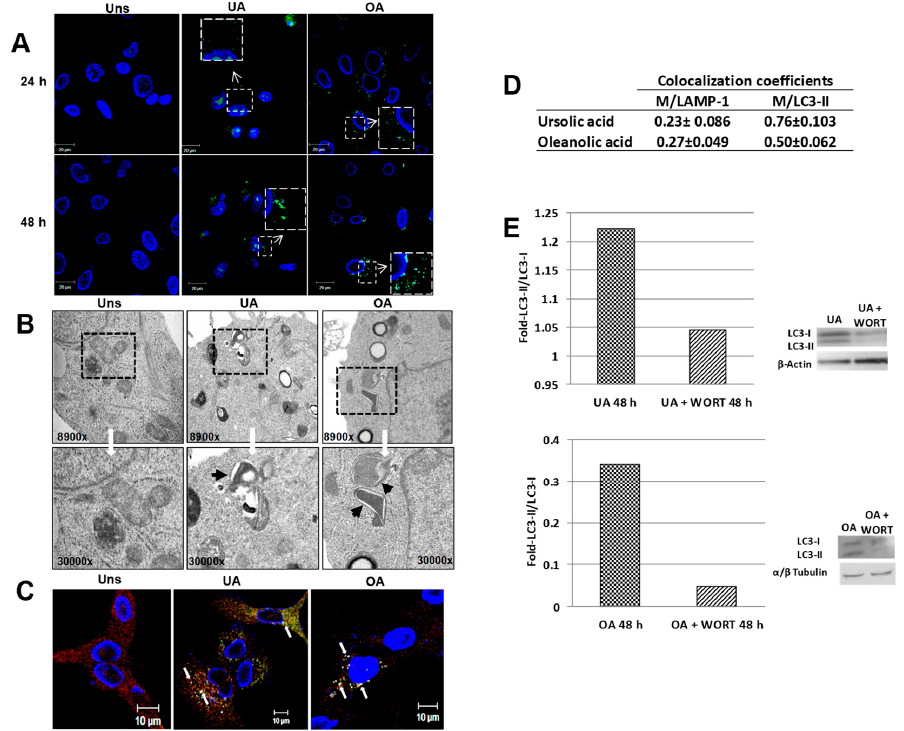
Figure 2. Ursolic and oleanolic acids induced autophagy in A549 human lung cancer cells. ( A ) A549 cells unstimulated (Uns) or stimulated with 10 µg/mL ursolic acid (UA) or 20 µg/mL oleanolic acid (OA) for 2, 6, 24, and 48 h were fixed with 4% paraformaldehyde and washed with PBS. Subsequently, the cells were incubated with an anti-LC3A/B antibody at 4 °C overnight and an anti-goat IgG-FITC antibody at 37 °C for 4 h. Autophagosomes are shown in green puncta; the field magnification of induced autophagosomes are showed in a large square. ( B ) Cells unstimulated (Uns) or stimulated with ursolic acid (10 µg/mL) or oleanolic acid (20 µg/mL) for 48 h were fixed with 2.5% glutaraldehyde and post fixed with 1% osmium tetraoxide. Subsequently, the cells were dehydrated with ethanol and embedded in resin, and sections of 50 nm were obtained with an ultramicrotome. The field magnifications are shown in large squares and double membrane vesicles (autophagosomes) are shown with dark arrows. ( C ) Cells unstimulated (Uns) or stimulated with 10 µg/mL of ursolic acid or 20 µg/mL oleanolic acid for 48 h were fixed with 4% paraformaldehyde and washed with PBS, and subsequently the cells were incubated with anti-LC3 A/B and anti-LAMP1 at 4 °C overnight and then with anti-goat IgG-FITC and anti-mouse IgG-Rhodamine at 37 °C for 4 h. Autolysosomes are shown with white arrows. ( D ) The quantitative colocalization analysis of LAMP-1 with LC3-II signals (M / LAMP-1) and LC3-II with LAMP-1 signals (M / LC3-II) was performed with ImageJ Fuji to determine Mander’s coe ffi cients from 0 to 1 (0 = non-overlapping images and 1 = colocalized images). No significant di ff erence was found when both acids were compared. ( E ) Representative images of western blot for LC3 and quantitative analysis of LC3-II / LC3-I ratio. In some experiments 5 mM wortmannin (WORT) was